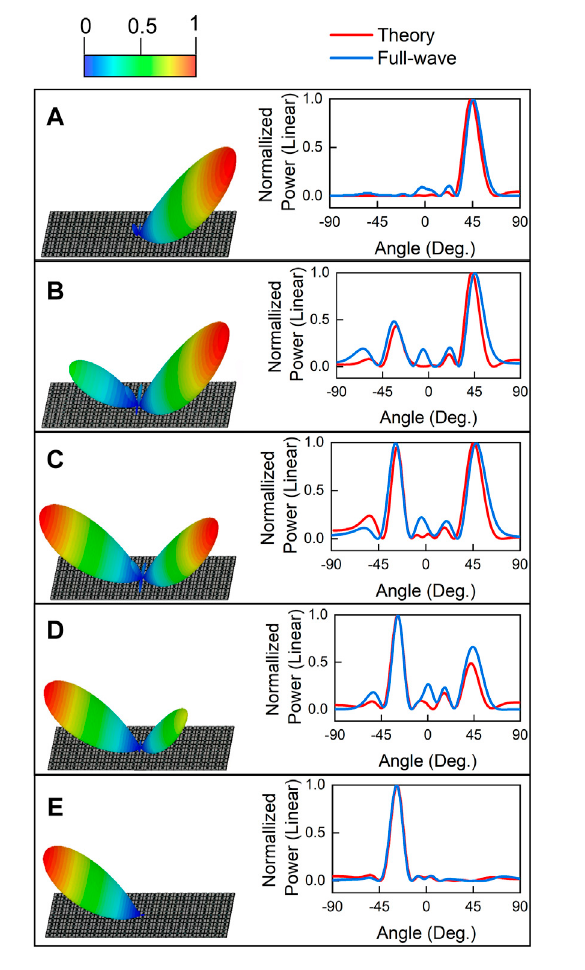
FIGURE 8 | The 3D scattering patterns of dual beams pointing at -21 ° and 37 ° simultaneously, with power intensity ratios of (A) 0:1 (B) 0.5:1 (C) 1: 1 (D) 1: 0.5 (E) 1:0 and their corresponding 2D scattering